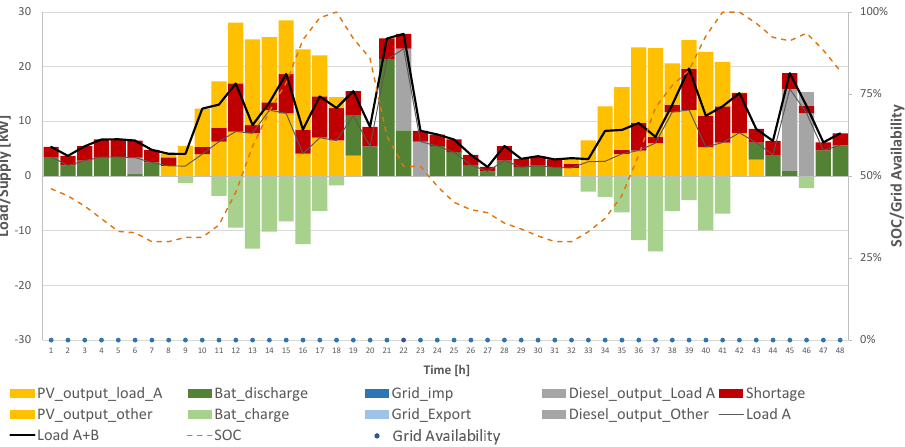
Figure 10. UMG optimal dispatch for rainy season and unreliable grid. Dry Season Isolated Grid